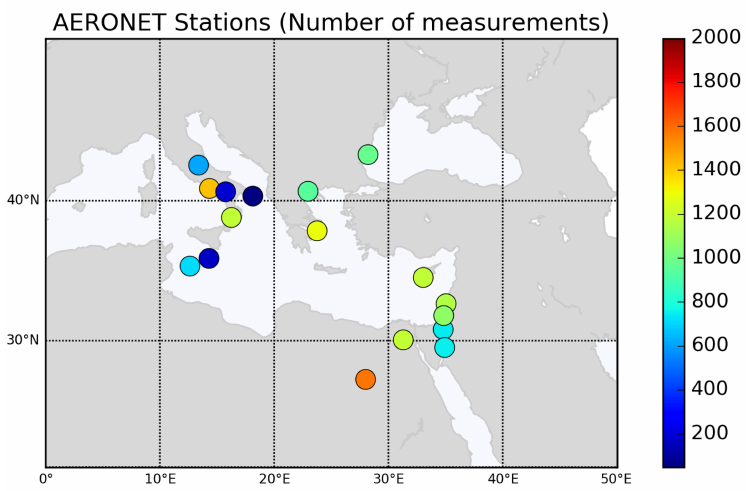
Figure 6. Map of the AERONET stations used for the validation of MODIS AOD assimilation run during the desert dust event over the eastern Mediterranean. The colour code refers to the number of observations in each station used within the period of comparison: February–April